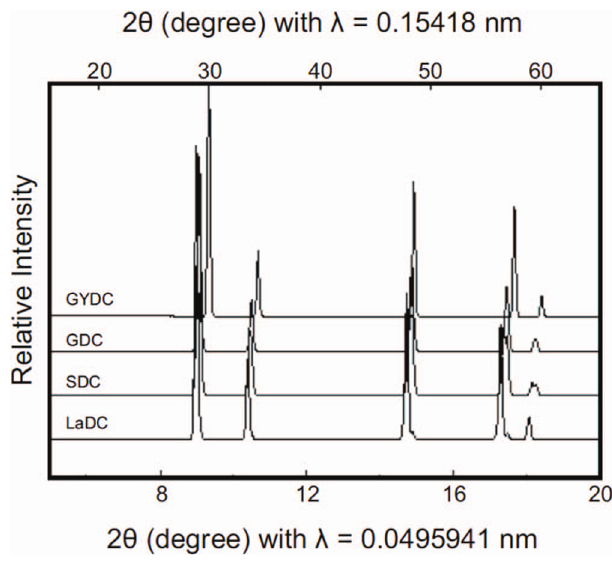
Fig. 3. XRD diagram of the RDC series oxides sintered at 1000 (cid:1) C for 10 h. The angle of diffraction 2 h values are for X -wavelength 0.15418 nm (top) and 0.0495941 nm